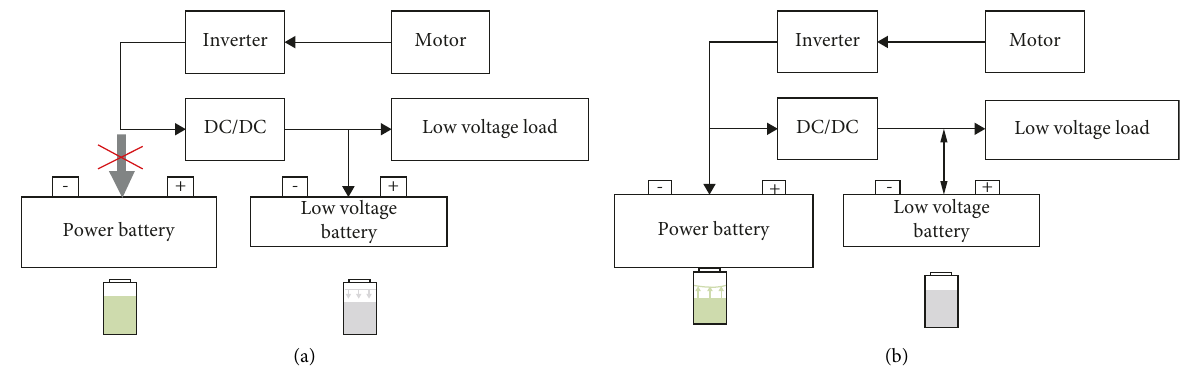
Figure 8: Energy management of energy recovery. (a) Energy management when the low power of the power battery permitted charge power of the power battery. (b) Energy management when the sufficient power of the power battery permitted charge power of the power battery.